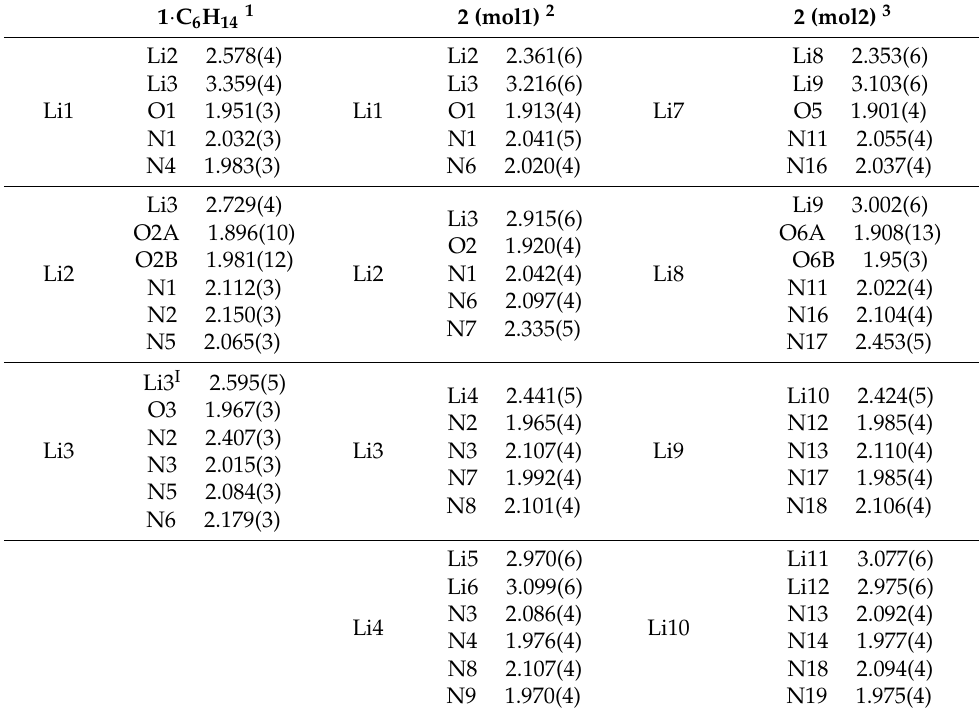
Figure 3. Molecular structure of 1 , viewed approximately along the twofold axis passing through N3 and N6. Color code: Li (purple), C (dark gray), N (blue), O (red), and Si (yellow). Thermal ellipsoids are at 60% probability level. Hydrogen atoms and the minority component of the disordered thf molecule bound to Li2 are omitted for clarity. Atoms with symmetry code “I” are obtained by rotation around the twofold axis. Table 1. Most significant interatomic distances (Å) in 1 ·C 6 H 14 and 2 .